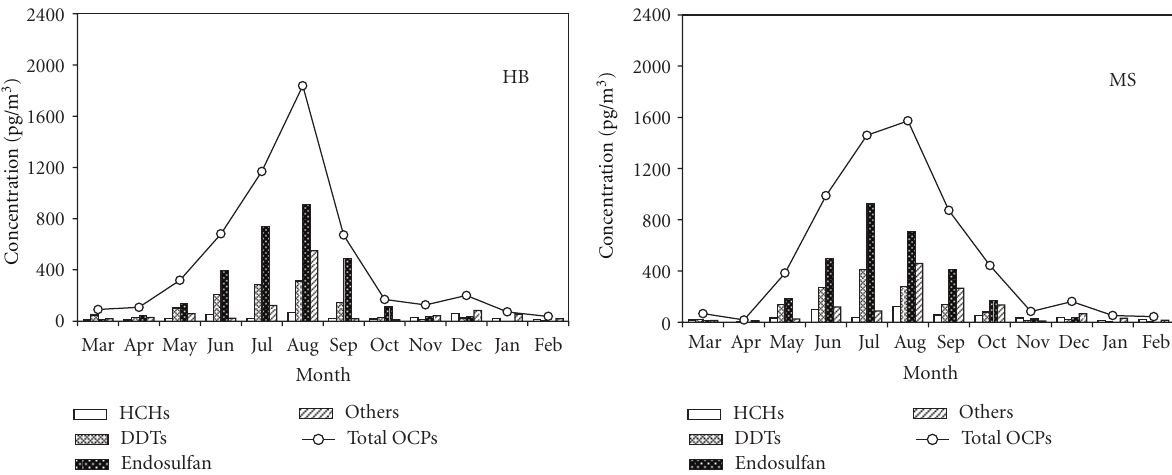
Figure 5: Temporal distributions of OCPs in the gas phase at the HB and MS sampling sites from March 2010 to February 2011.